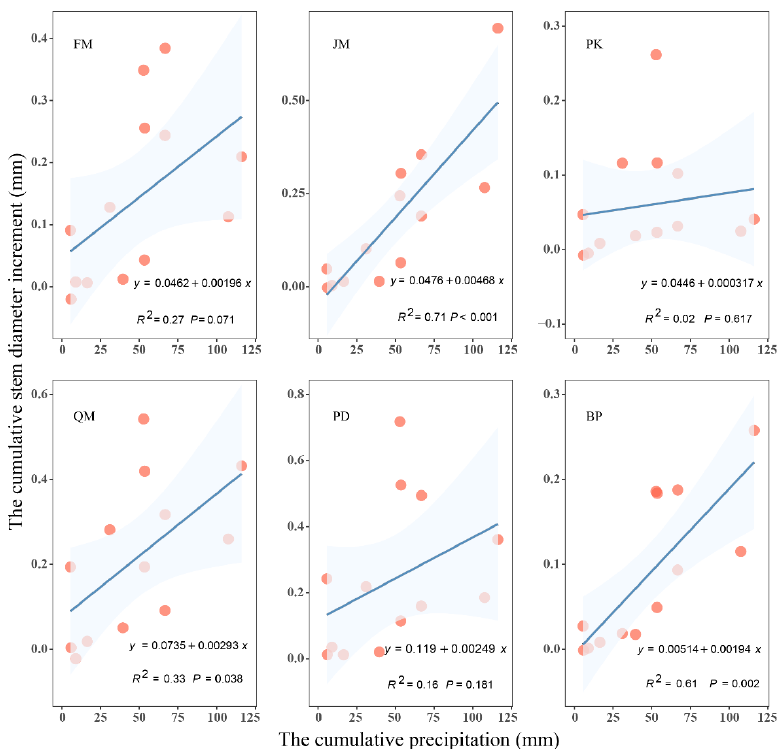
Figure 2. The relationship between the stem diameter increment and the cumulative precipitation of six tree species. The light blue area is the 95% con fi dence interval. FM: Fraxinus mandshurica ; JM: Juglans Mandshurica Maxim.; PK: Pinus koraiensis Sieb. et Zucc.; QM: Quercus mongolica Fisch.; PD: Populus davidiana Dode.; BP: Betula platyphylla Suk. There was signi fi cant correlation between the stem radial variation (SRC) of stems and the water condition characteristics (Figure 3). The results showed that the stem radial change (SRC) of six tree species during the growing season (DOY121-273) had a signi fi cant positive correlation with precipitation ( p < 0.001) and relative humidity ( p < 0.001) and had a signi fi cant negative correlation with VPD ( p < 0.001).